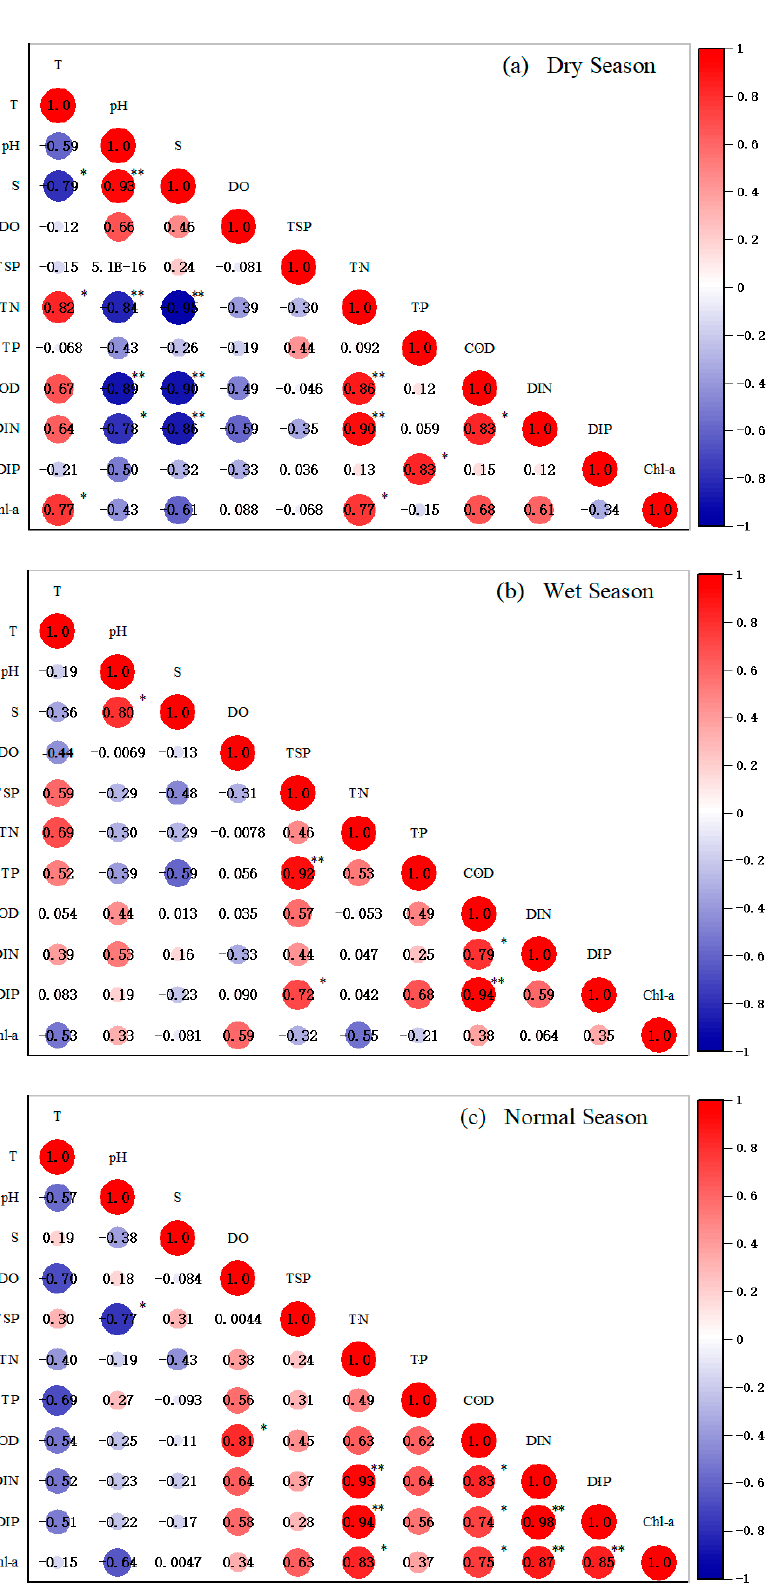
Figure 6. Spearman correlation coefficients of influencing factors on TN and TP concentrations in the Maowei Sea ( n = 8). Note: * refers to correlations significant at p < 0.05 (two-tailed) and ** refers to correlations significant at p < 0.01 (two-tailed).